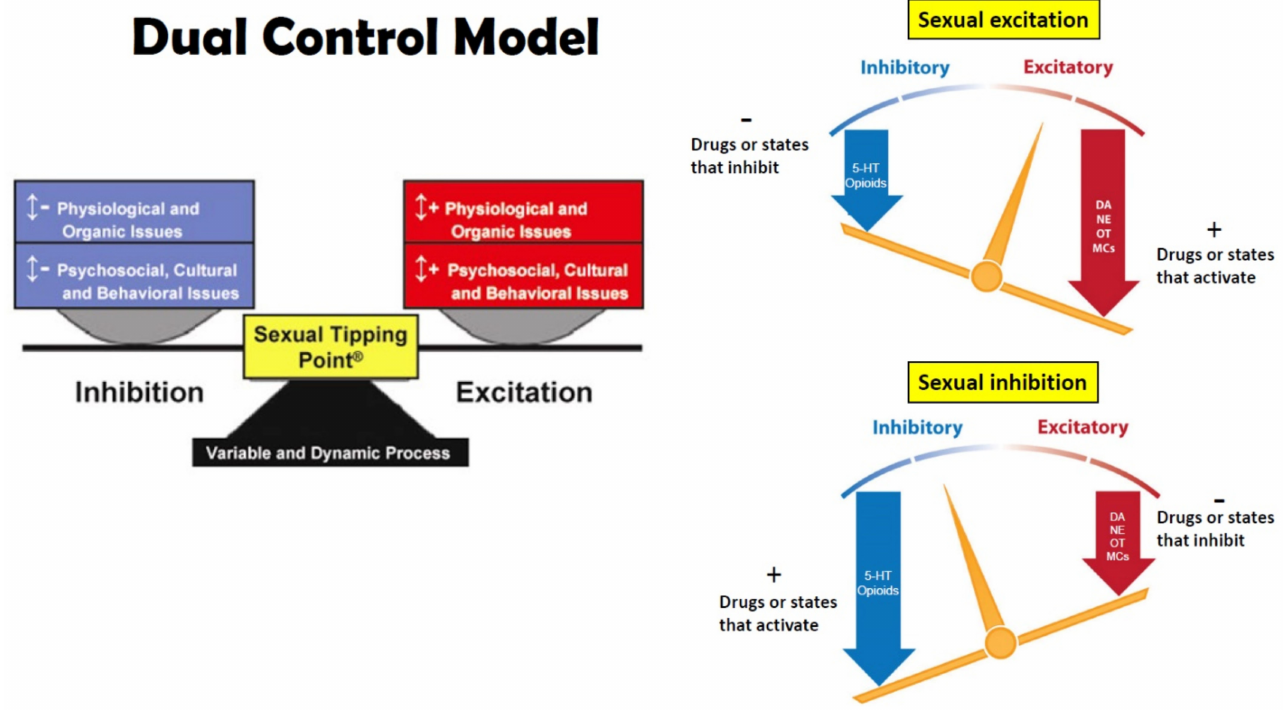
Figure 2. Left: dual control model of Perelman [1] (Reprinted with permission from Perelman, 2006, Wiley) that depicts sexual excitation and inhibition forming around a labile sexual tipping point. The dual-control model is based on work by Bancroft and Janssen [4], who based their model on the work of Gray [24] for fear conditioning. Gray, in turn, based his ideas on those of Pavlov [25] for the role of excitation and inhibition of cortical function in conditioned reflexes. Right: neurochem- ical mechanisms and processes associated with sexual excitation and inhibition. DA = dopamine, NE = norepinephrine, OT = oxytocin, MC = melanocortins, 5-HT = serotonin, reprinted with permis- sion from Pfaus [3] (2009,